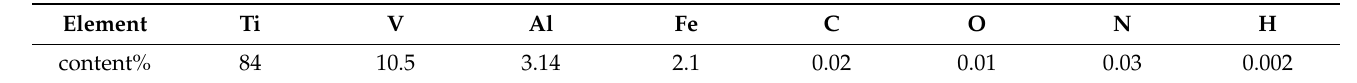
Table 1. Chemical compositions of the studied Ti-1023 titanium alloy.